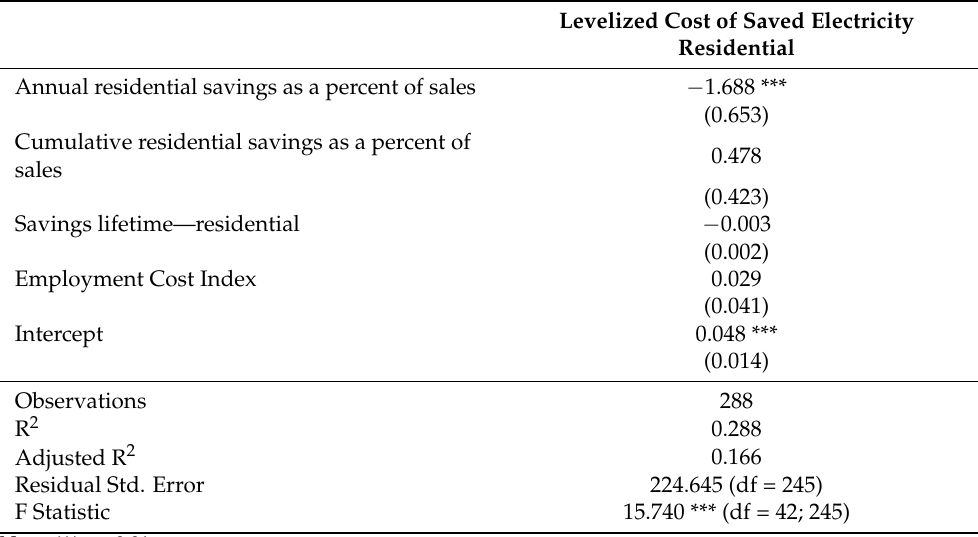
Table A3. Regression results for residential programs